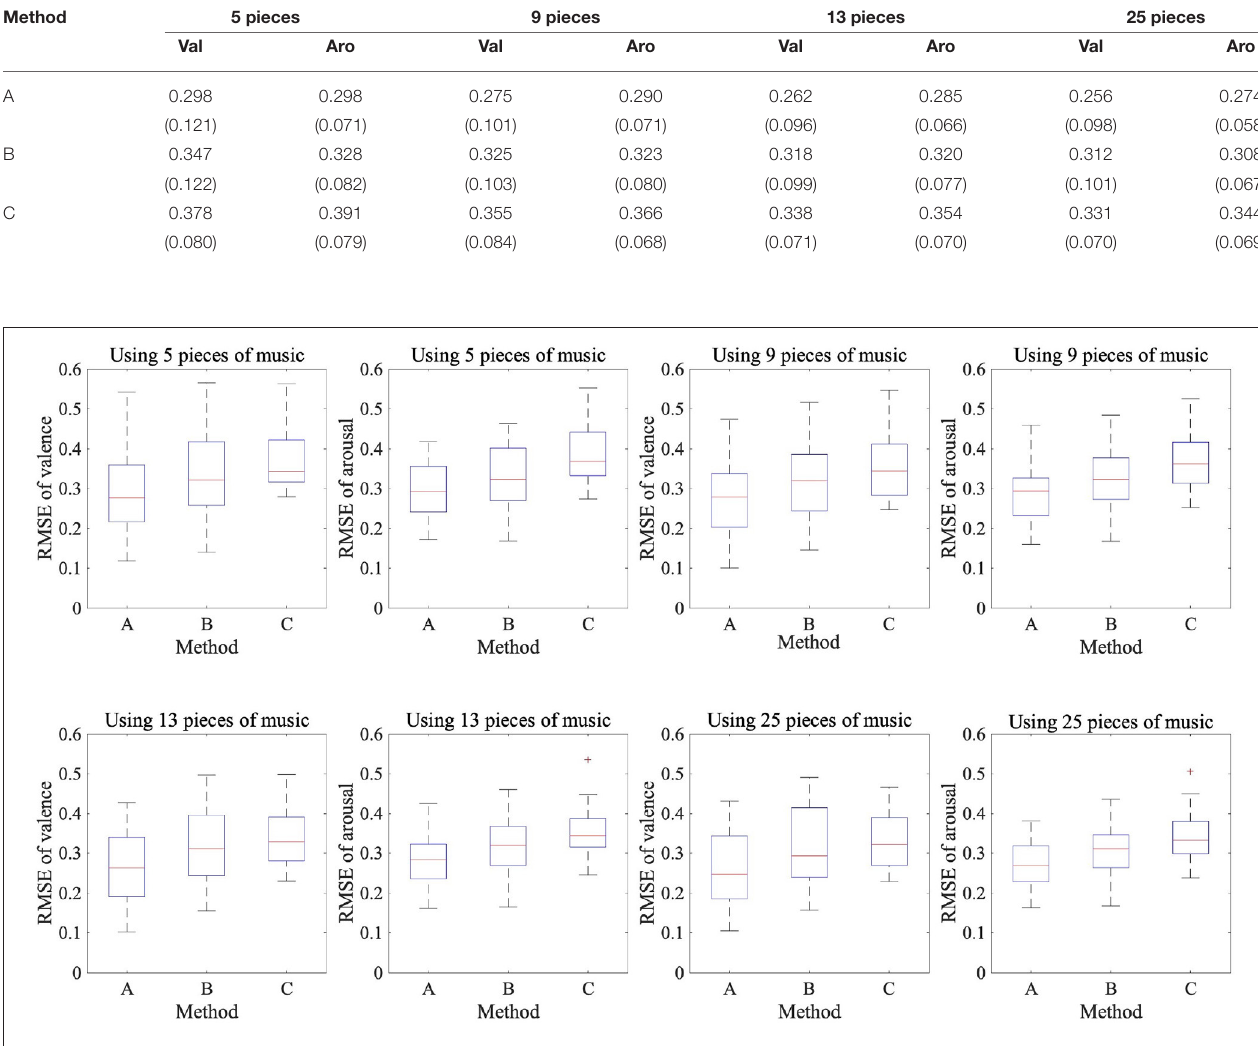
FIGURE 3 | Box plots of 20 participants’ RMSEs of felt and predicted emotions using EEG